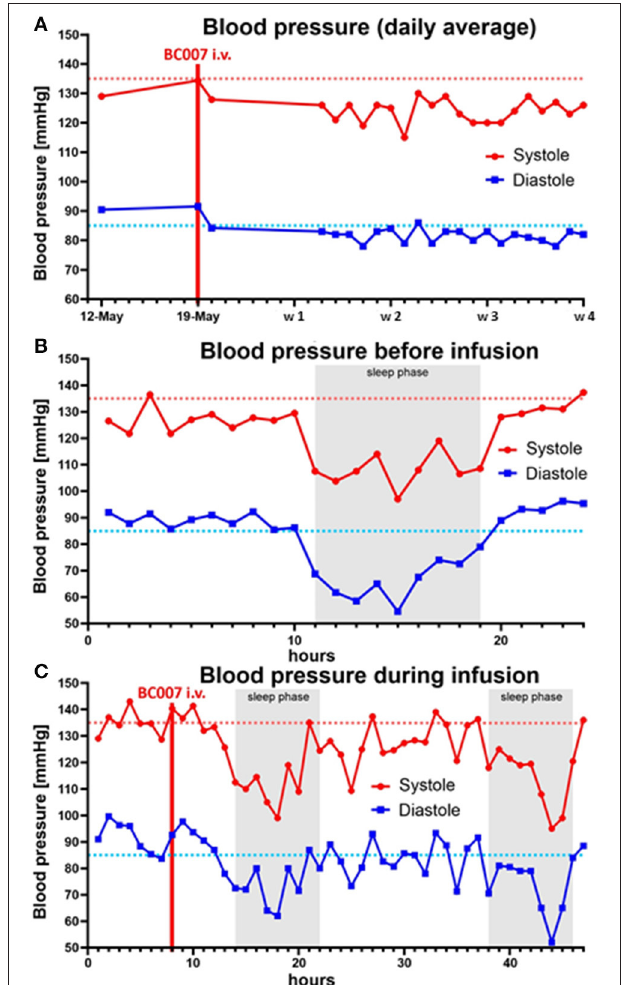
FIGURE 1 | Blood pressure (systolic, diastolic, mmHg) before (A) , during (B) , and after treatment with BC 007 (C) : a reduction of the diastolic blood pressure was observed after the elimination of functional active G-protein-coupled receptor autoantibodies [GPCR-AAb; w-week; dotted line: individual target level of systolic (red) and diastolic (blue) blood